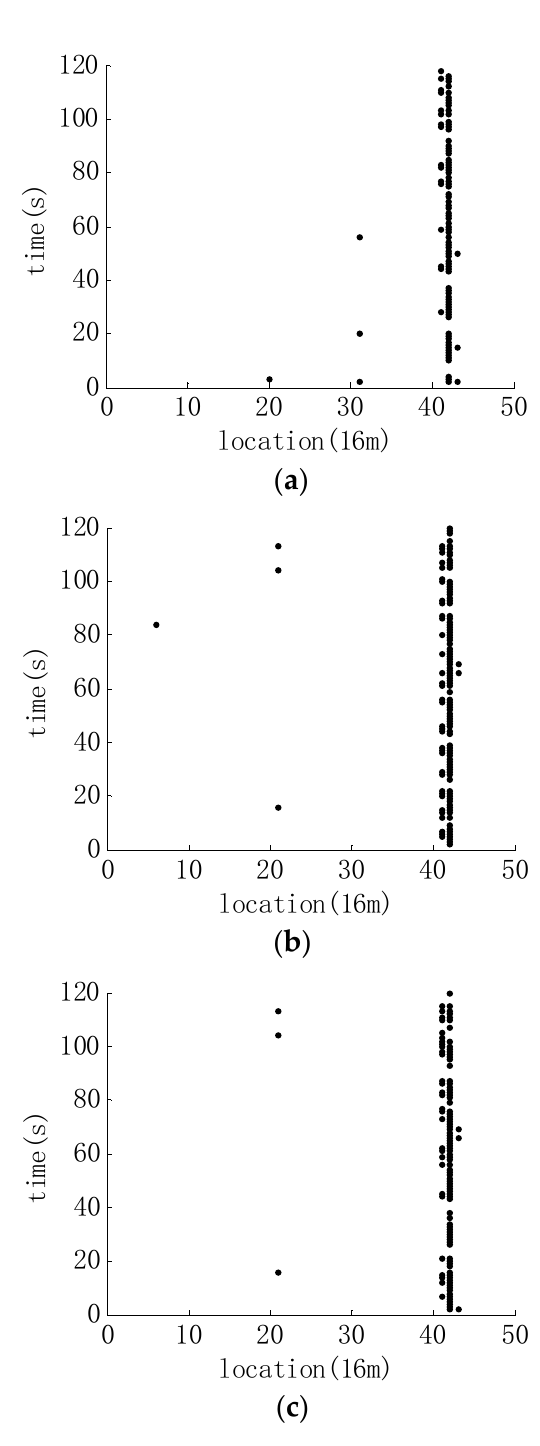
second group of walking signals; ( c ) The thrid group of walking signals.